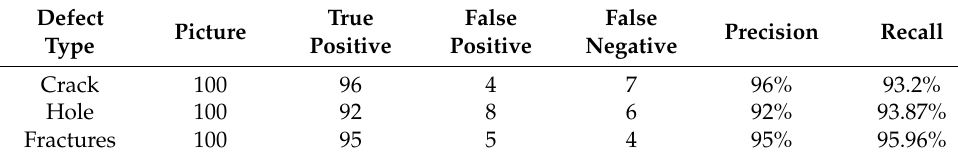
Table 2. Resnet 50 defect classification results.